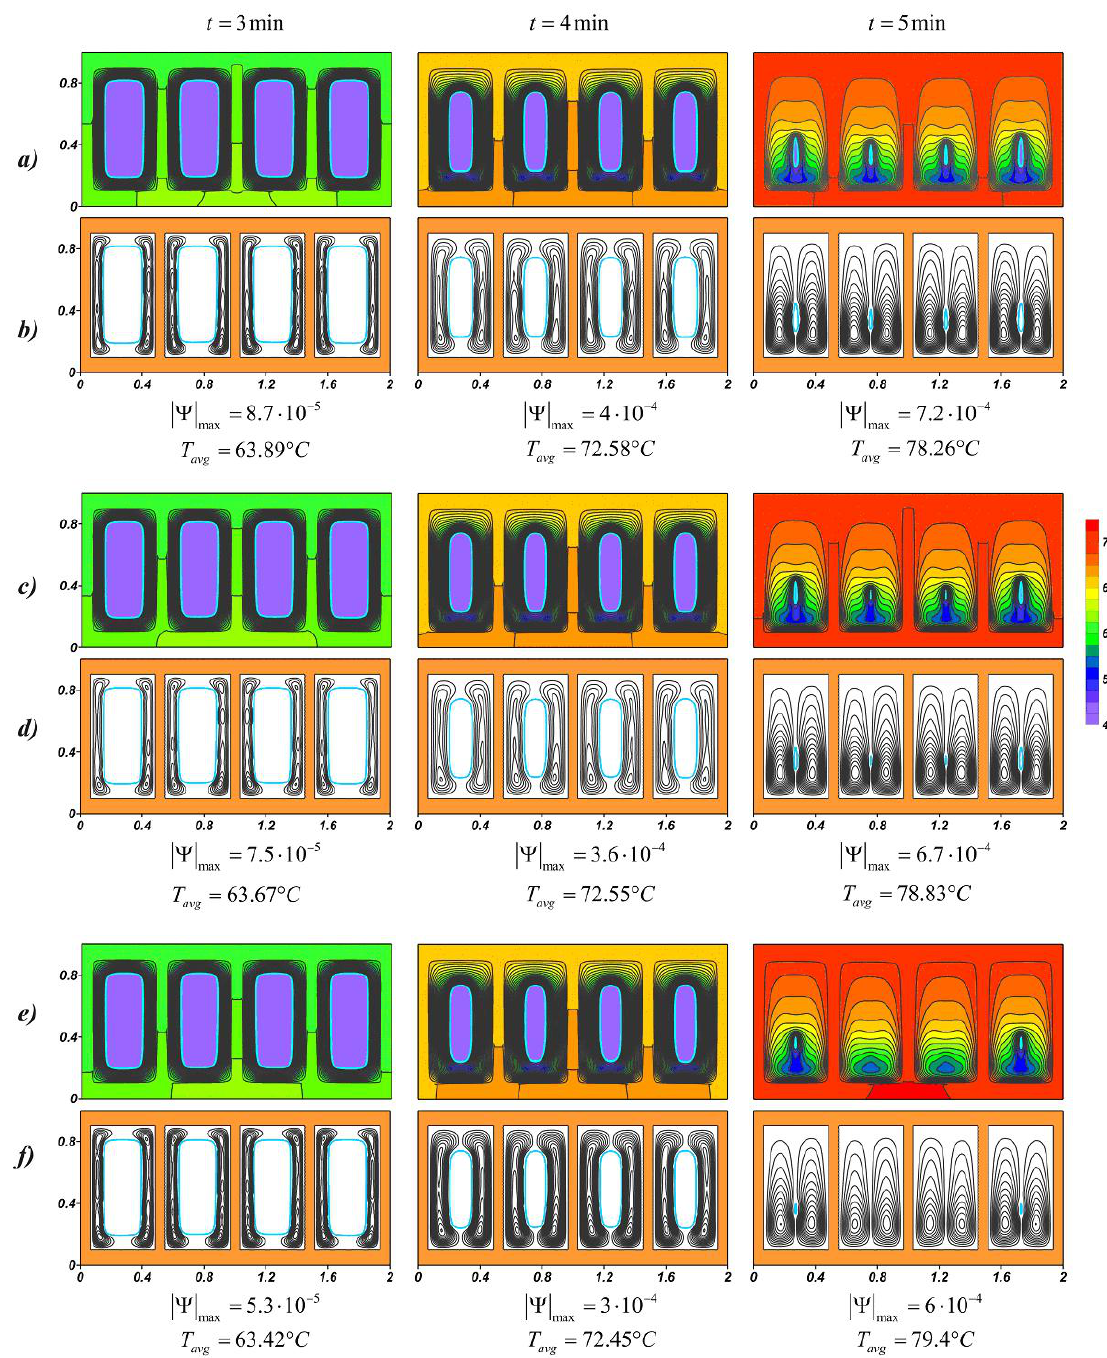
Figure 5. Temperature fields and streamlines for lauric acid at different time moments: ( a , b ) Φ = 2%; ( c , d ) Φ = 4%; ( e , f ) Φ = 6%.